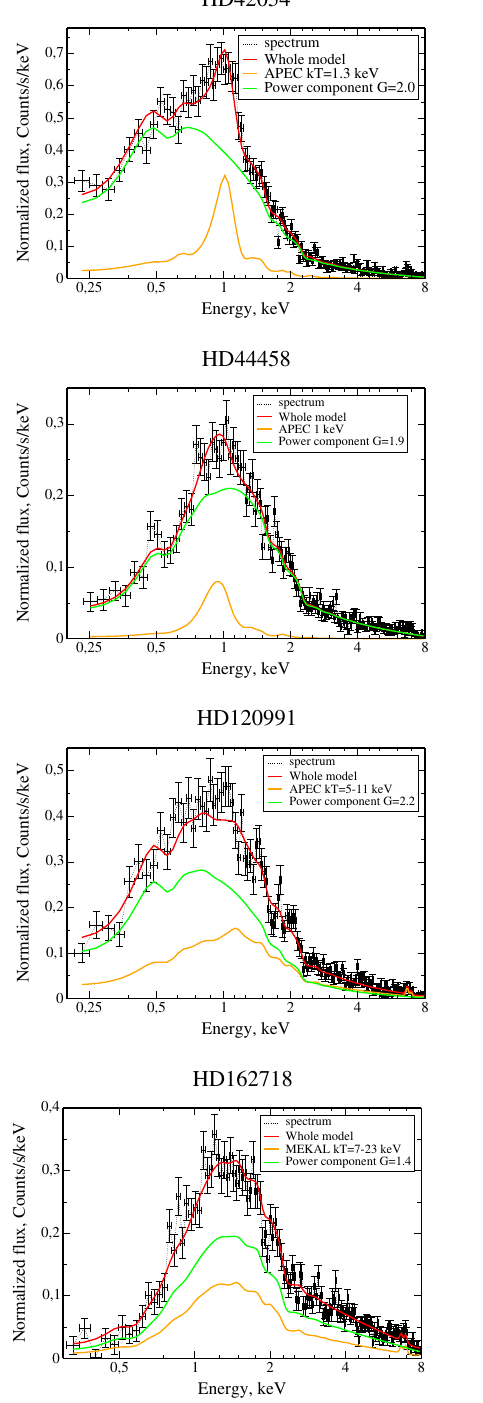
Figure 4. The same as in Figure 1 but for APEC/MEKAL+PL models with fixed spectral index G = 1.5. Table 4 shows the results of the model fits for combina- tions of both one of the thermal models APEC/MEKAL